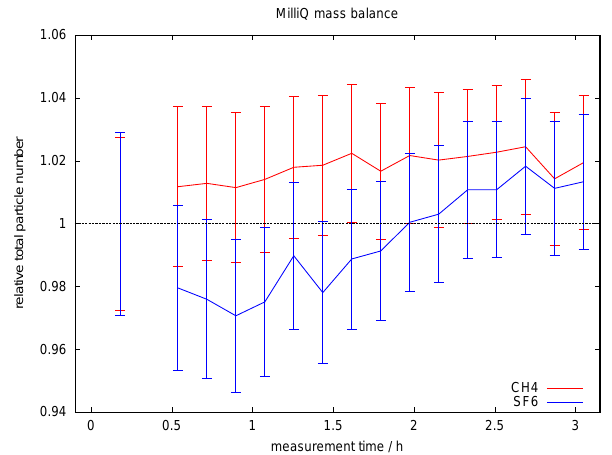
Figure 7. Total amount of gas in the tank according to Eq. (14), nor- malised to the first measurement, vs. time of a typical gas exchange experiment with Milli-Q water. It shows that no gas is measurably lost or acquired during the experiment.